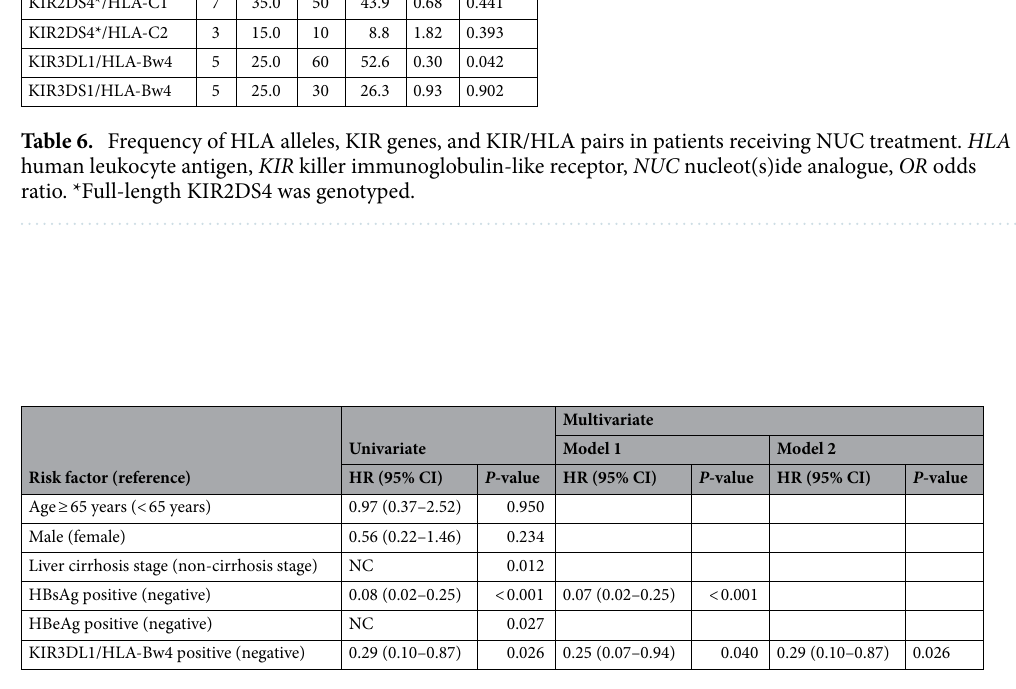
Table 7. Independent risk factors of NUC treatment freedom in HBV patients by logistic regression analysis. Model 1 included all risk factors in calculations. Model 2 included age, gender, and KIR3DL1/HLA-Bw4